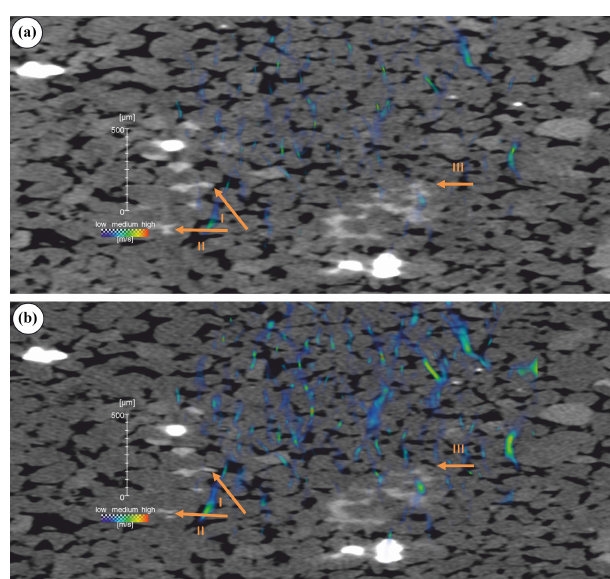
Figure 8. In (a) and (b) the identical Permian sandstone sample is presented before (a) and after (b) CO 2 experiments under reservoir conditions. The images are enhanced sections from Fig. 7 and verify the dissolution of the blocky pore-filling cements (arrows) and the enhanced fluid flow field and fluid flow velocities after the experi- ments resulting from the dissolution events (blue to red